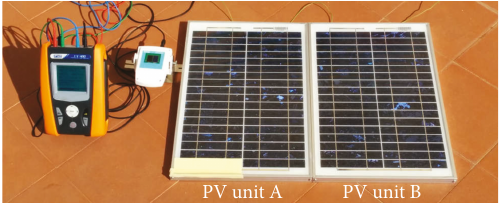
Figure 6: PVUs in mismatching conditions. 26 September 2017, Aversa (CE), Italy. S 1 = 616W/m 2 characterizes the unshaded cells, and S 2 = 145 W/m 2 characterizes the shaded cell; T amb = 25 ° C .